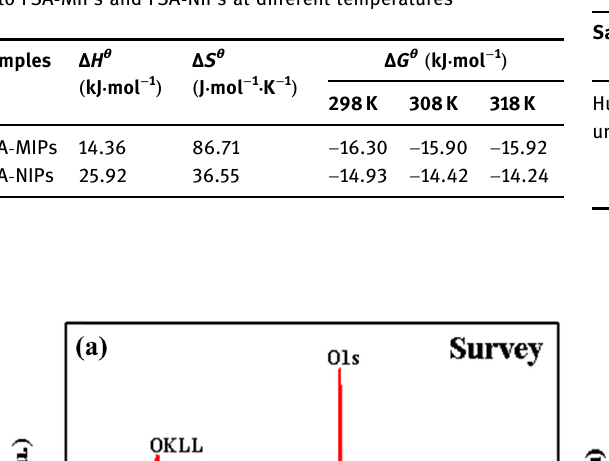
Table A4: Recoveries of 4 - MMC obtained from human urine samples Table A3: Thermodynamic parameters for the adsorption of 4 - MMC